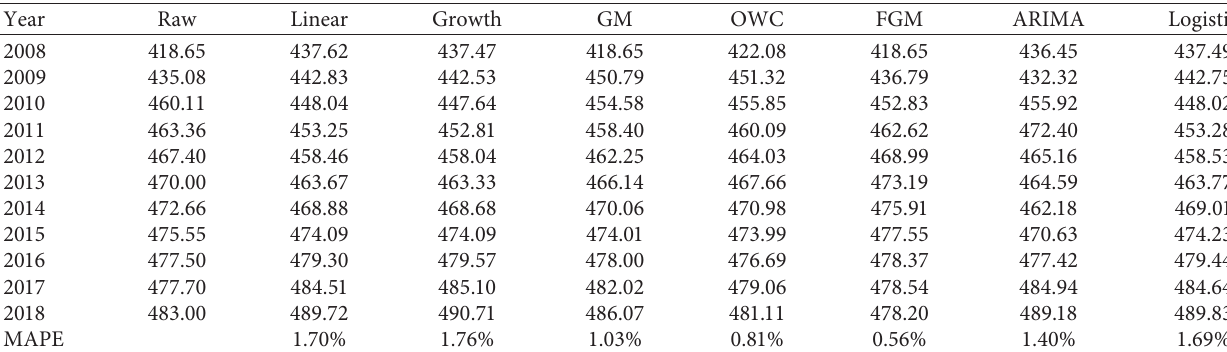
Figure 1: Huizhou population estimated results of various Table 1: Estimated results of Huizhou population with various models, units: 10,000.